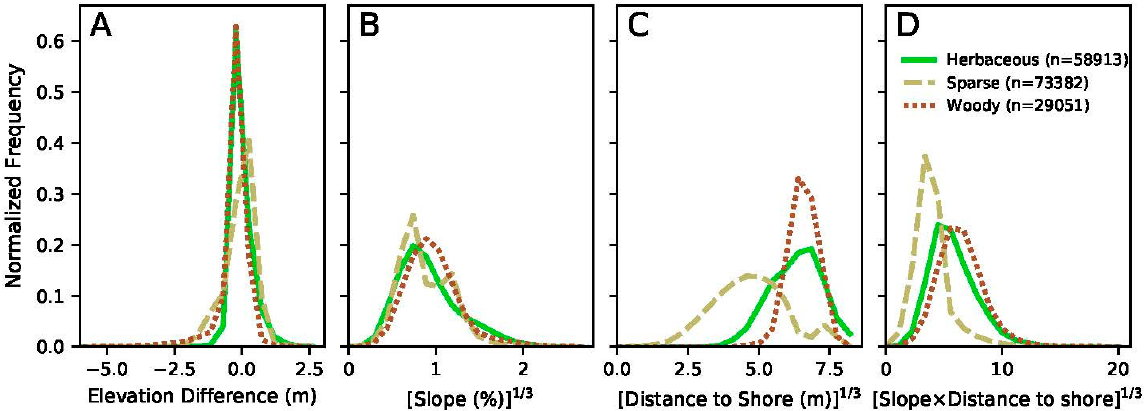
Figure 4. Frequency distributions, normalized by the sum of cells per habitat, of the transformed DEM-derived parameters (( A ) = elevation difference, ( B ) = Slope, ( C ) = distance to shore, ( D ) = slope × distance to shore).